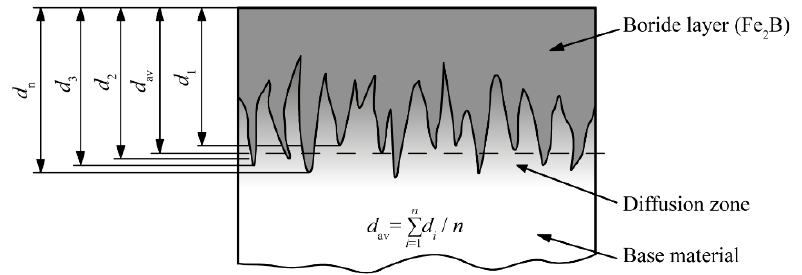
Figure 1. Determining the average thickness of the boride